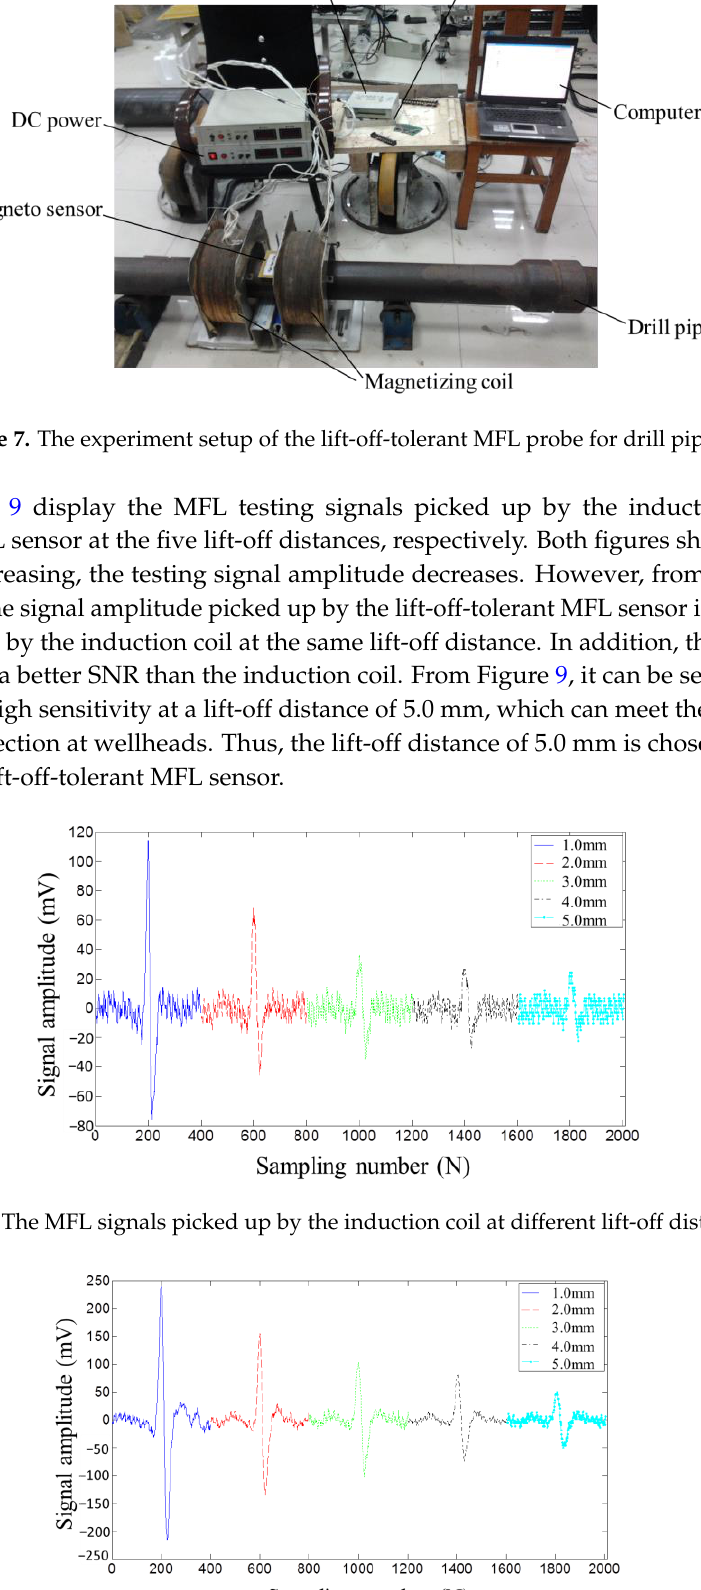
Figure 9. The MFL signals picked up by the lift-off-tolerant MFL sensor at different lift-off distances.